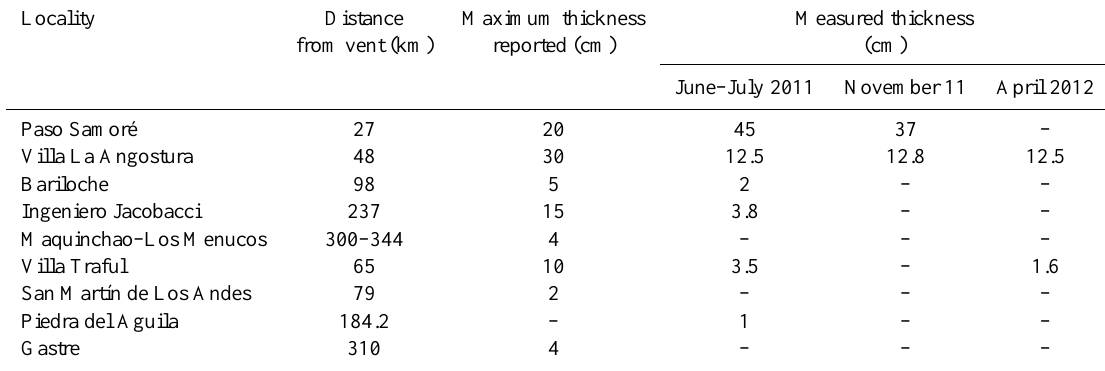
Table 7. Comparison of thickness of tephra fallout as reported in the media and measured in the field (Pistolesi et al., 2015). Locality Distance Maximum thickness Measured thickness from vent (km) reported